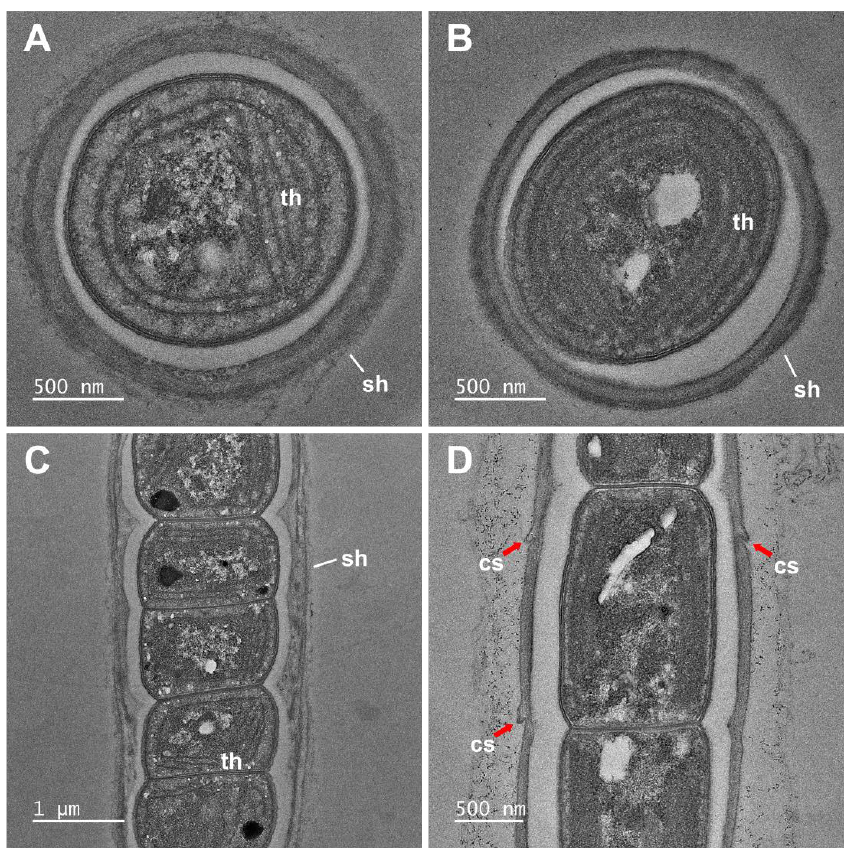
Figure 3. Ultrastructure of Trichotorquatus salinus FBCC-A1483. ( A , B ) Cross section of the trichome, circular in shape; ( C , D ) Longitudinal section of the trichome; ( A – C ) Parietal position of thylakoids (th) and single filaments with sheaths (sh); ( D ) Red arrows showing collar sheath (cs). Description: Filaments unbranched, Scytonema -type or Tolypothrix -type false branch- Table 1. Morphological characteristics of genus Trichotorquatus as described by Pietrasiak et al.